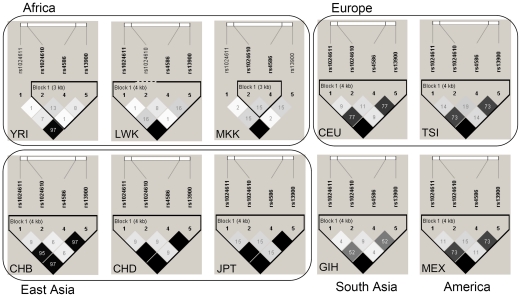
Pairwise LD (r
2) plots of CCL2 variants in different populations based on preliminary data extracted from the HapMap Phase 3 release.YRI, Yoruban in Ibadan, Nigeria; LWK, Luhya in Webuye, Kenya; MKK, Maasai in Kinyawa, Kenya; CEU, the US residents of northern and western European ancestry; TSI, Tuscan in Italy; CHB, Han Chinese in Beijing, China; CHD, Chinese in Metropolitan Denver, Colorado; JPT, Japanese in Tokyo, Japan; GIH, Gujarati Indians in Houston, Texas; MEX Mexican ancestry in Los Angeles, California.